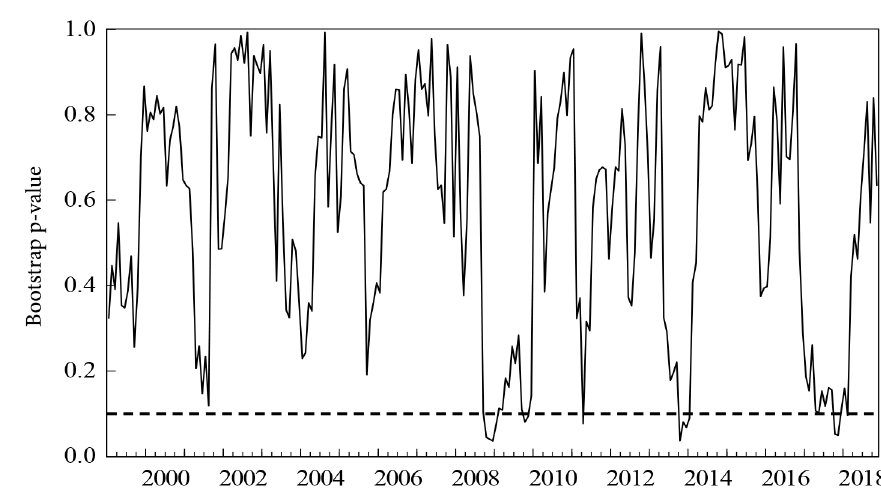
Figure 3. Bootstrap p -values of rolling test statistic testing the null hypothesis that GP does not Granger cause